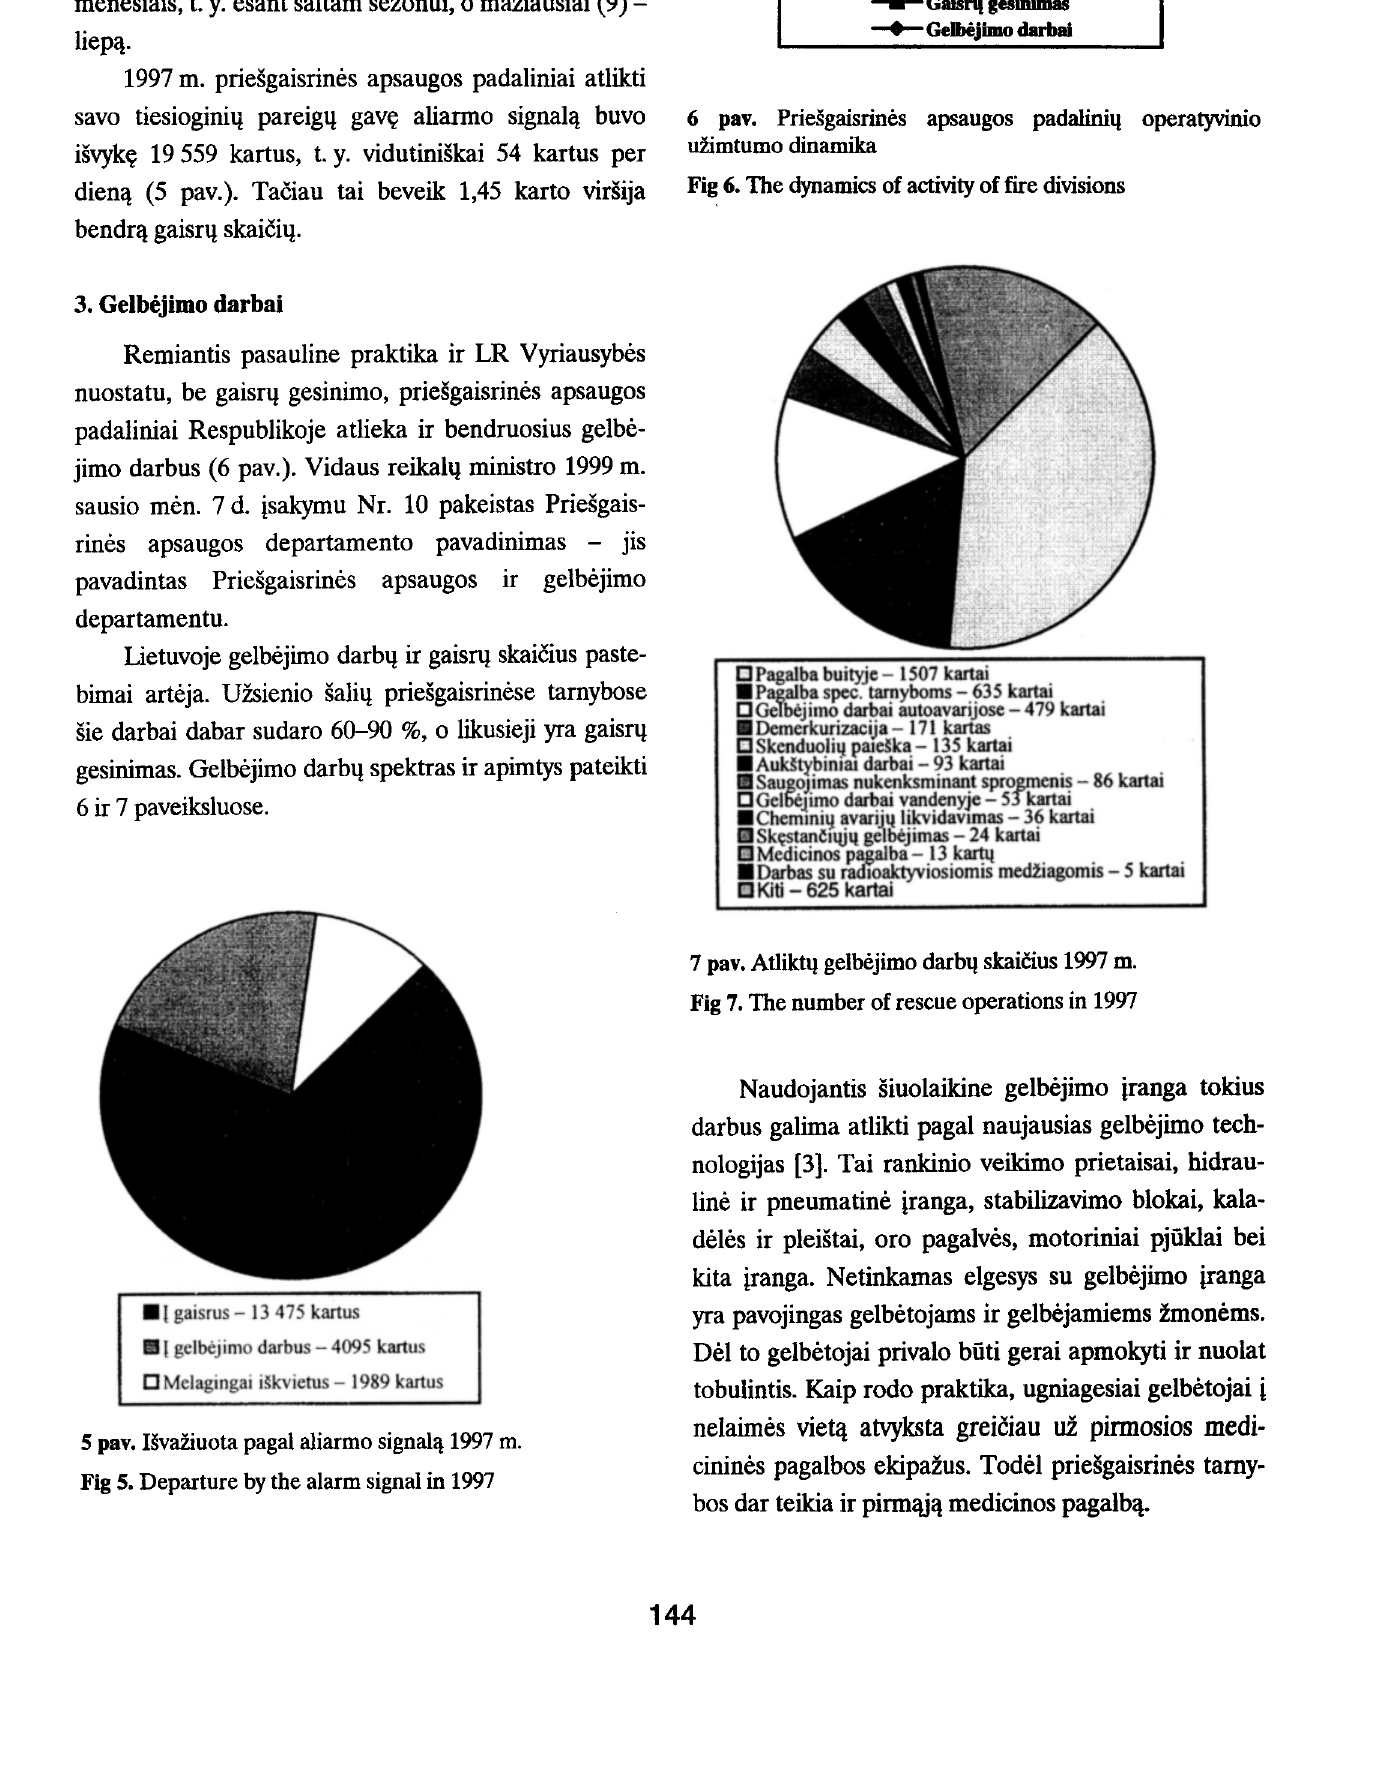
Fig 5. Departure by the alarm signal in 1997